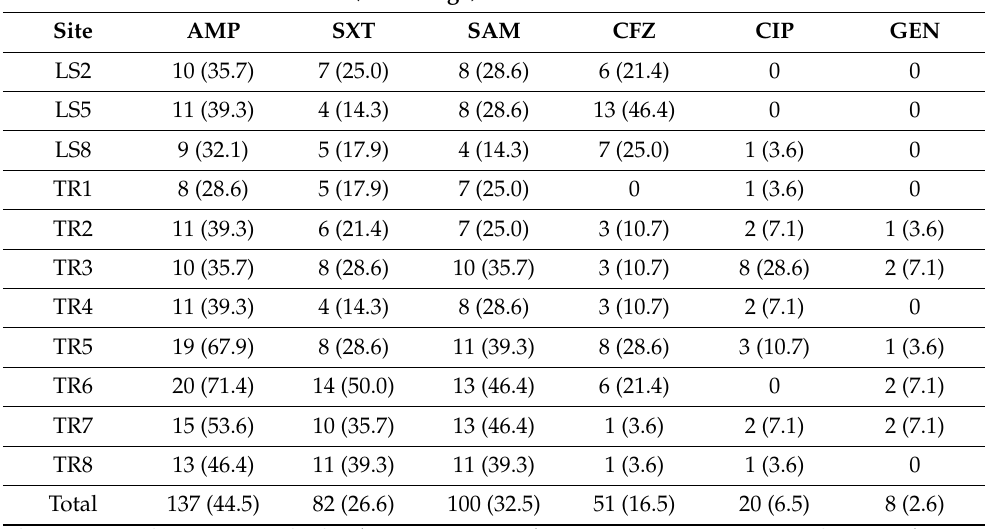
Table 3. Number (and percentage) of environmental isolates resistant to six antibiotics by sample site ( n =